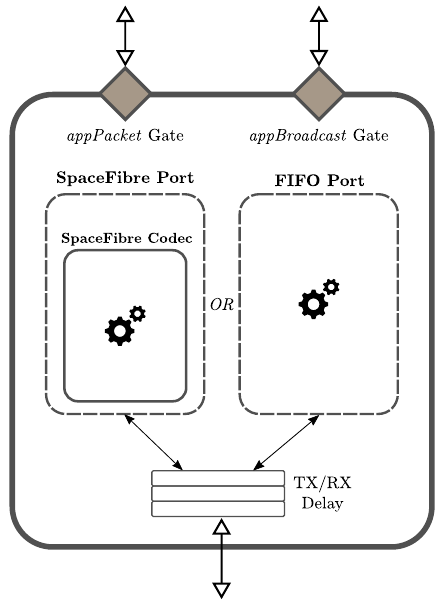
Figure 2. Internal architecture of a SpaceFibre